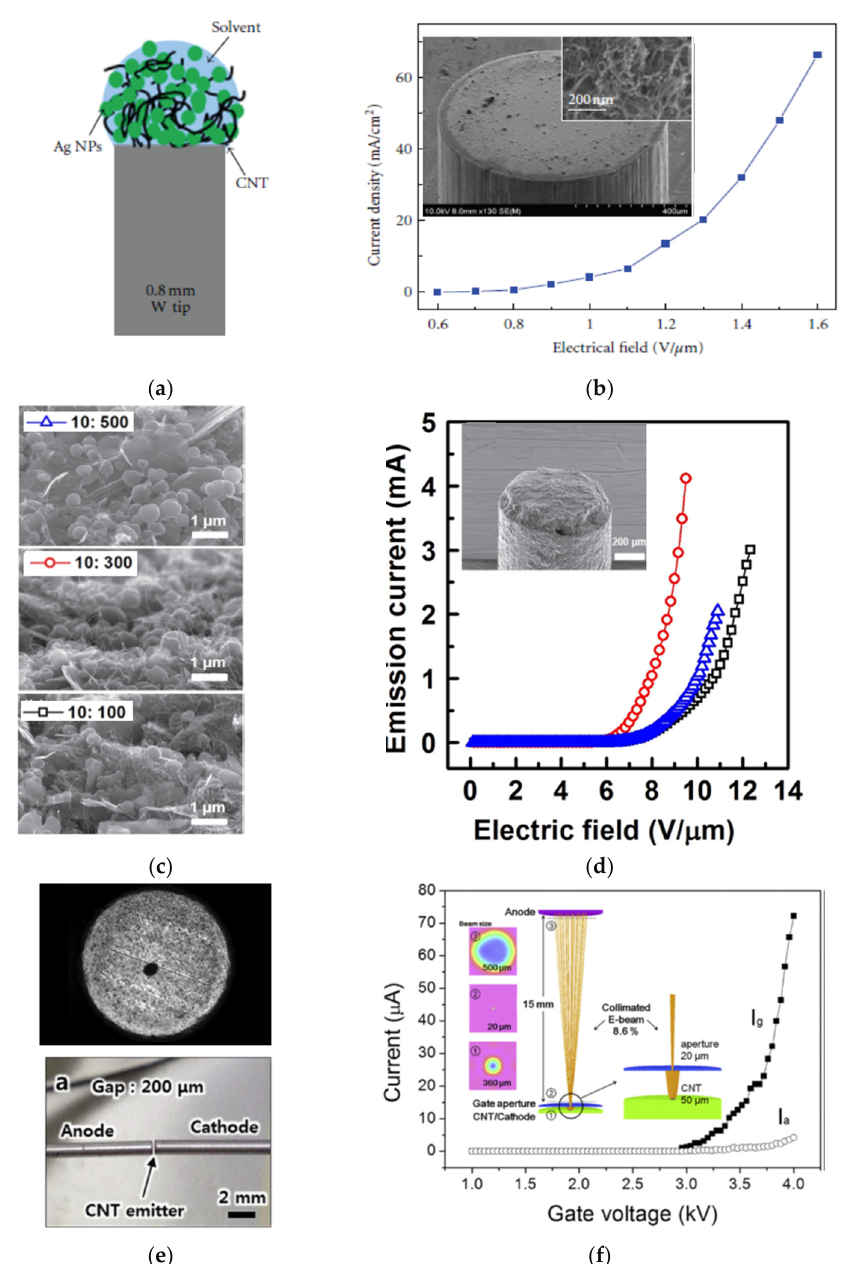
Figure 11. The CNT-FE cathode on tip: ( a ) a schematic illustration of the FE cathode on a tip, using a CNT suspension with silver nanoparticles (NPs); ( b , d ) the FE characteristic of the cathode, the inset—a zoom on a tip with drop-casted suspension; ( c ) SEM images of the surface of CNT cathode on a tip with various ratios of graphite powder and CNTs; ( e ) an OM image of the top of CNT-FE cathode (upper view); ( e ) the photography of the diode configuration, including the FE cathode on a tip (lower view); ( f ) I–V characteristic of the CNT FED in a triode configuration, and insets shows the simulated result of a collimated electron beam. Figure 11a,b from [2], Figure 11c,d from [116], and Figure 11e,f reprinted with permission from